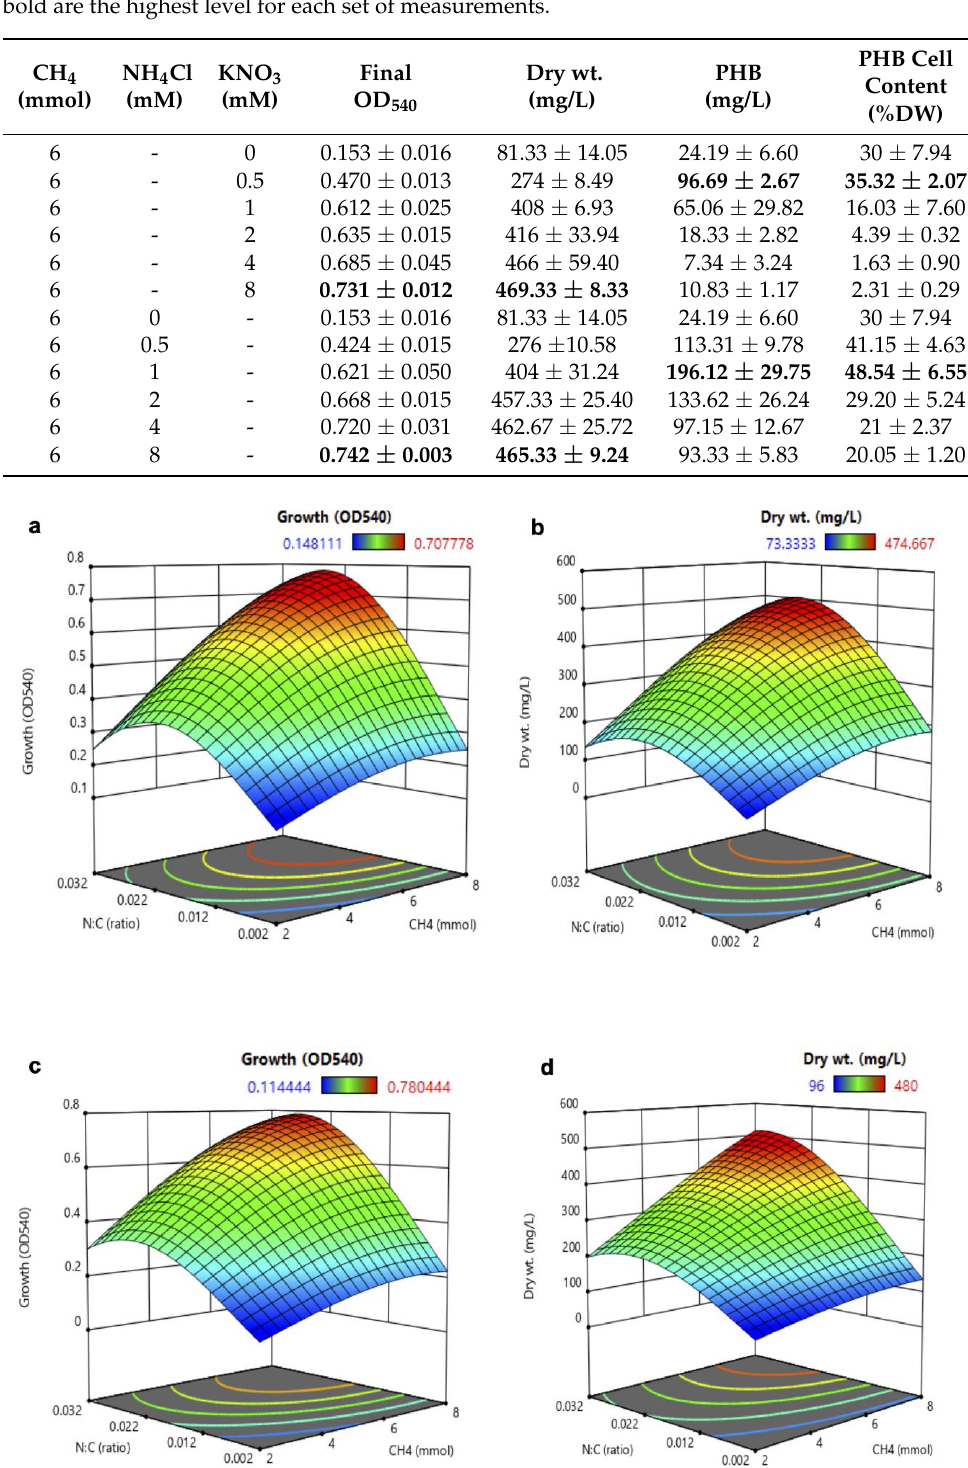
Table 2. Effect of nitrogen concentration (mM) on growth (optical density, OD, at 540 nm), biomass (dry weight, DW, in mg/L), and PHB production (mg/L culture and PHB% of cell dry weight, DW) in batch cultures of Methylocystis sp. Rockwell initially containing 6 mmol methane ( n = 3). Values in bold are the highest level for each set of measurements.